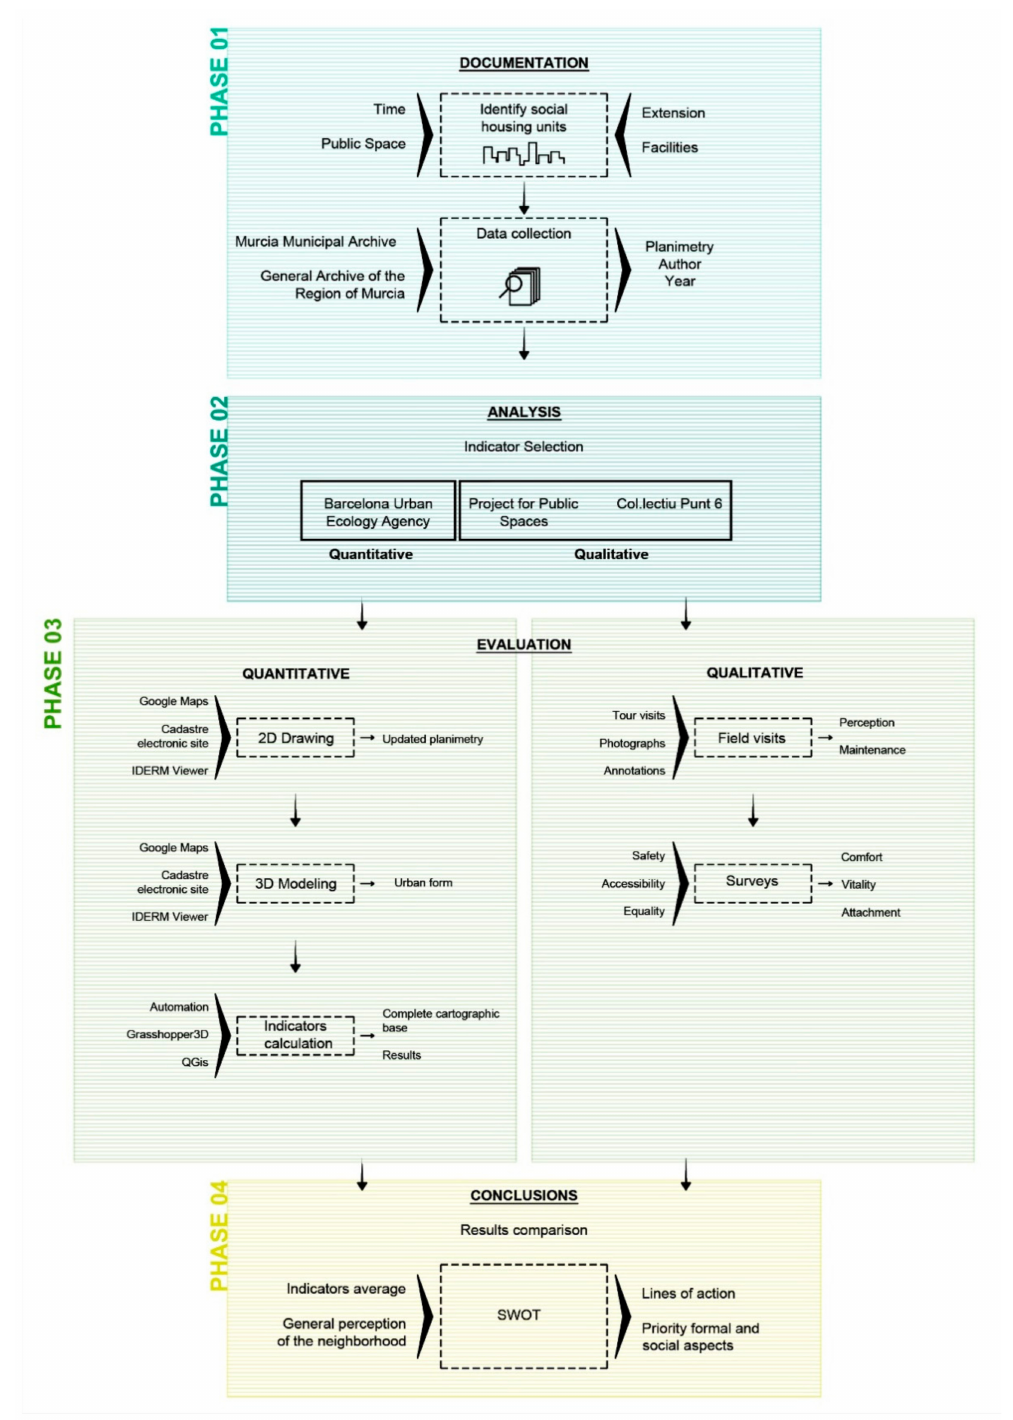
Figure 5. Flow chart of the whole process. Authors’